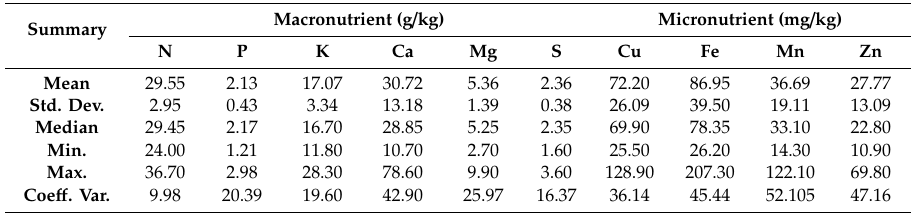
Table 3. Descriptive data from the chemical analysis of the Valencia-orange leaves.